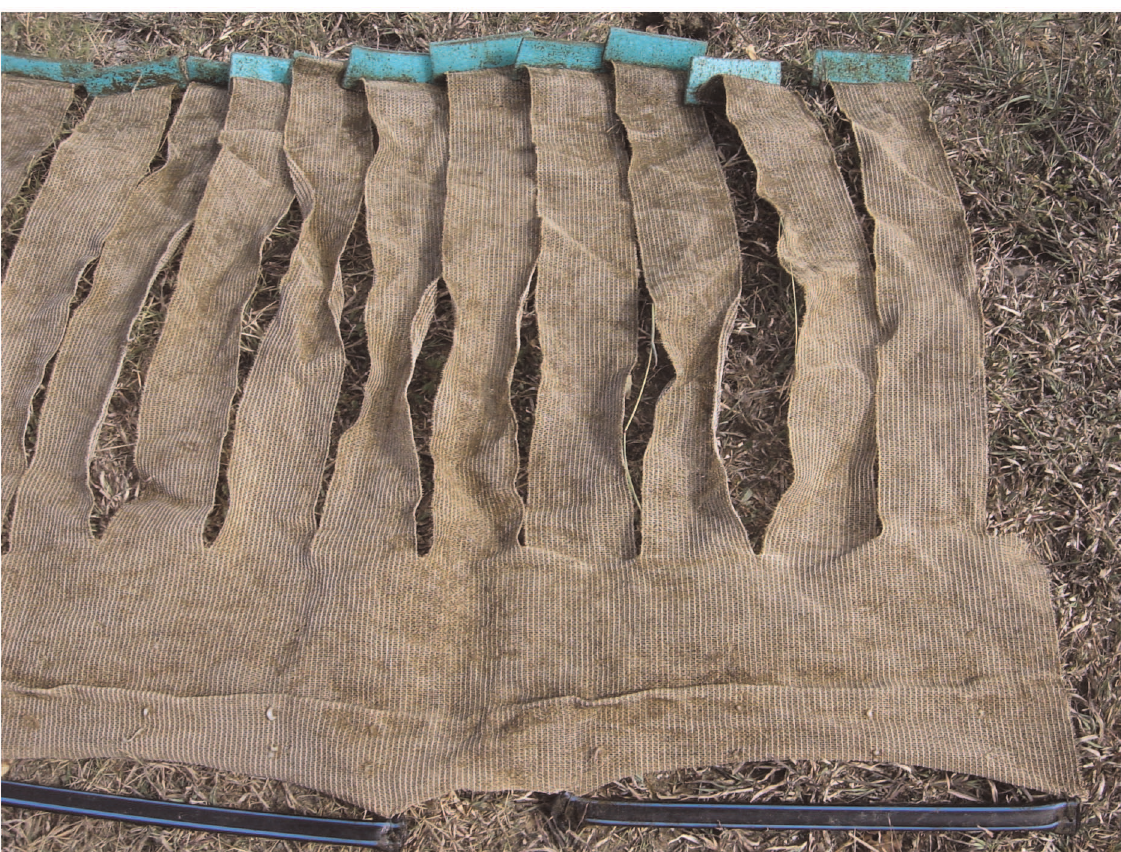
Figure 1. Stripped shadecloth unit. Photograph of the end of a stripped shadecloth unit used to increase the surface area of mesh inside fine- mesh enclosures. The sand-filled polypropylene tubes at the bottom of the photograph weigh down the woven polyethylene fabric while the foam pieces at the top kept the strips upright in the water.